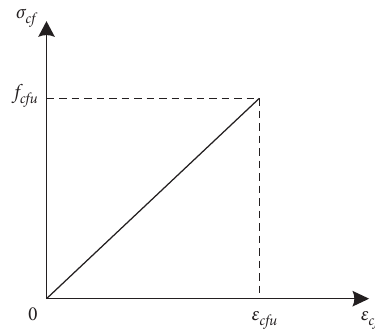
Figure 3: Stress-strain curve of the CFRP sheet.